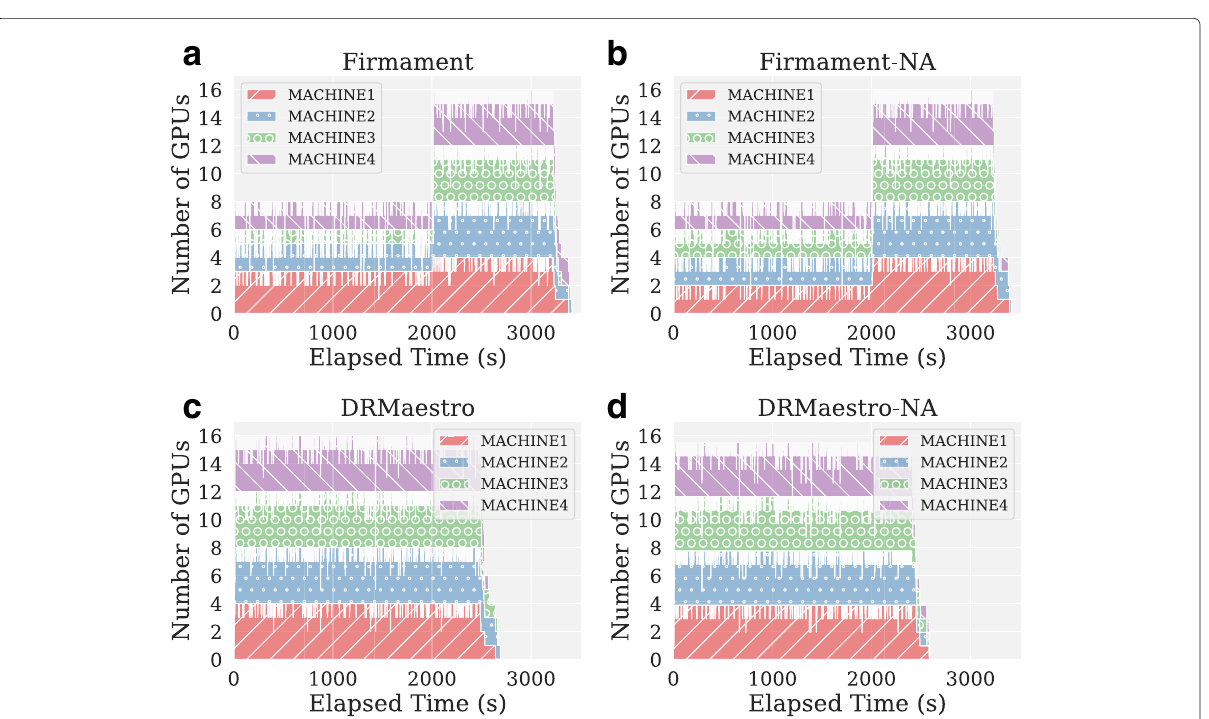
Fig. 5 Experiment results of orchestration with DRMaestro . Orchestration performed with DRMaestro with the implemented prototype in a cluster with 4 machines and 512